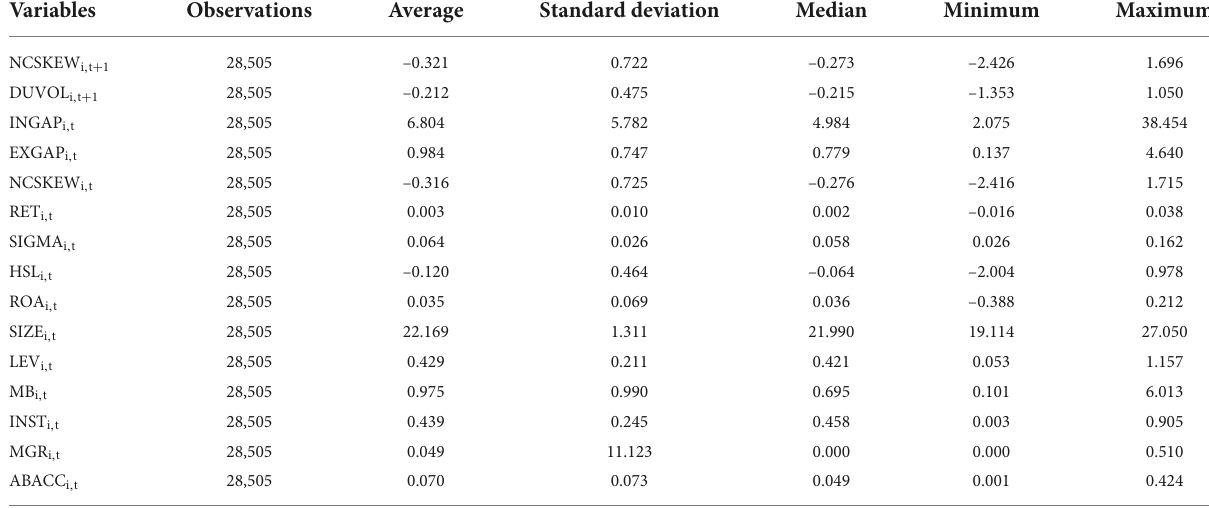
TABLE 2 Descriptive statistics of the main